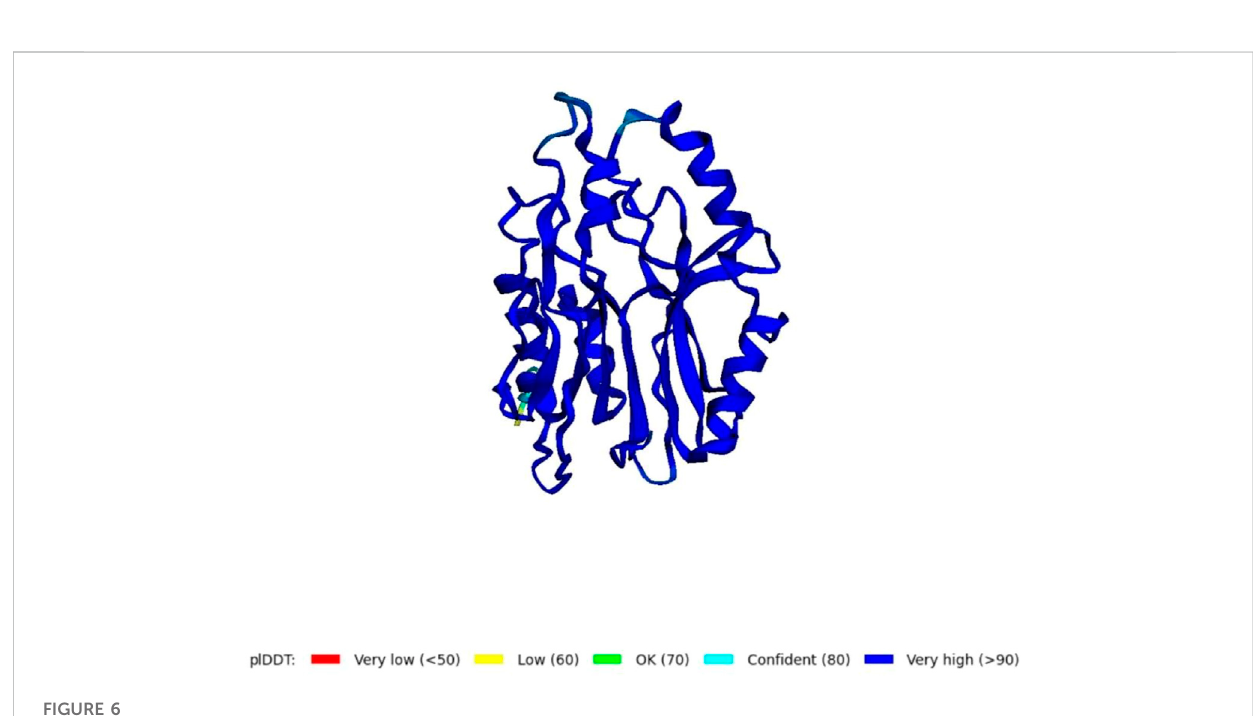
FIGURE 6 Prediction of a novel nitrilase structure using